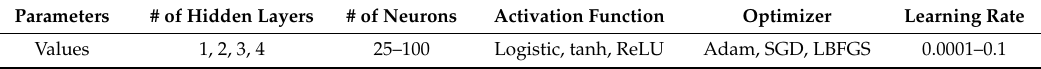
Table 2. The di ff erent parameters examined with NN